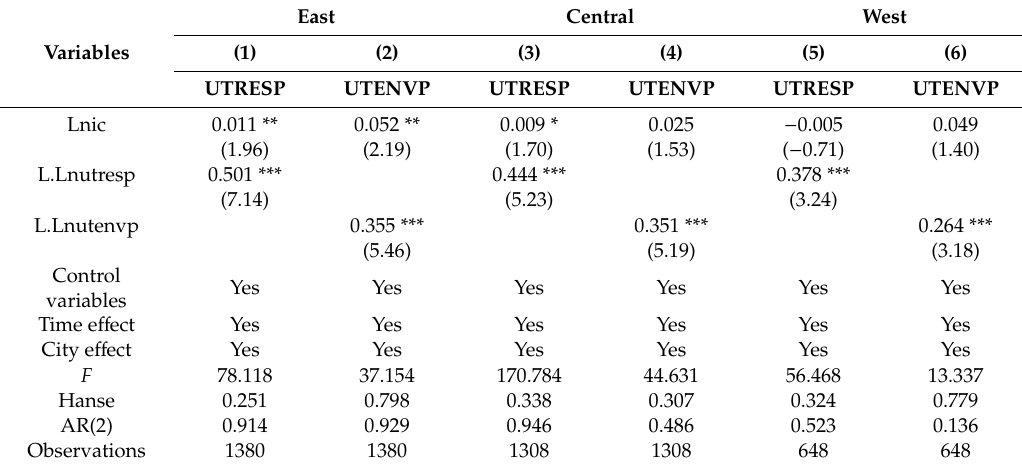
Table 6. Estimated results of eastern, central, and western